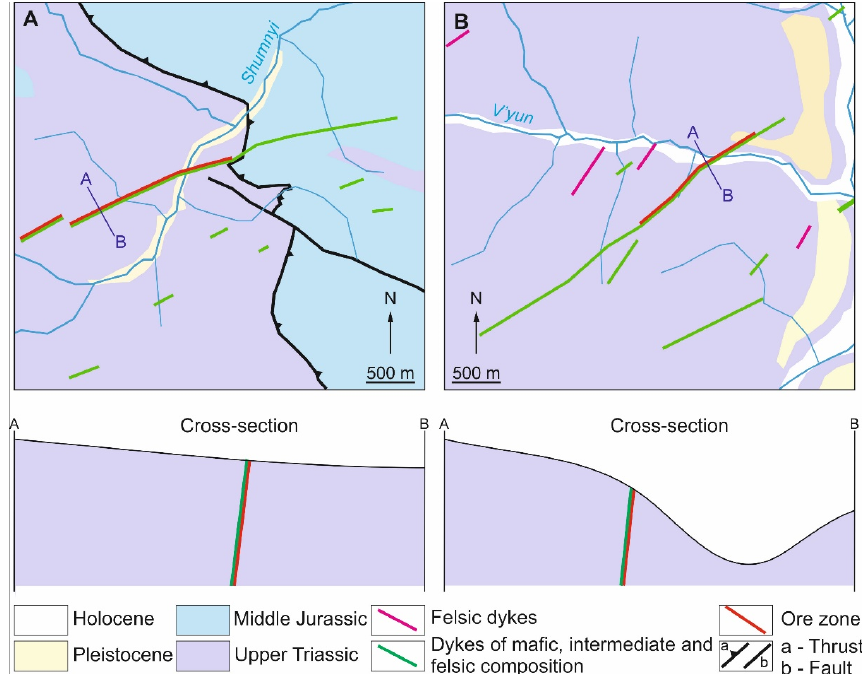
Figure 4. Geologic map and simplified cross ‐ sections of the intrusion ‐ hosted OGDs, central YKMB: ( A ) V’yun and ( B ) Shumnyi.